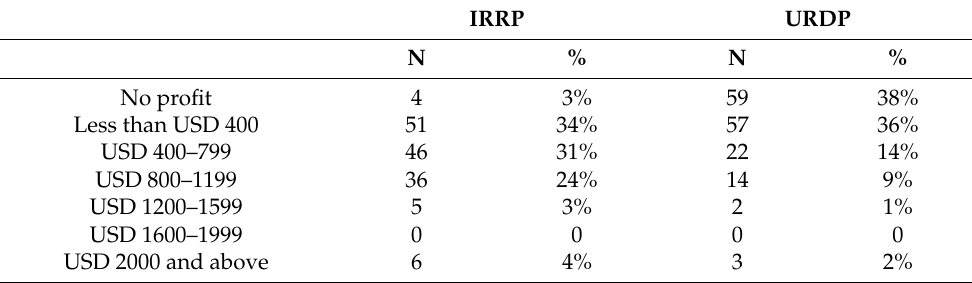
Table 3. Additional yearly income from